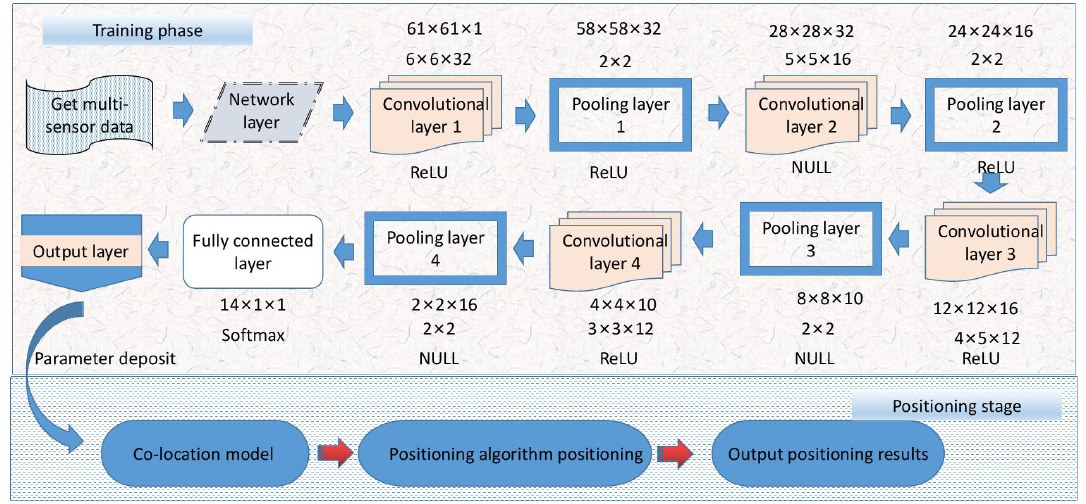
Fig. 1. Multi-sensor collaborative positioning model architecture based on dual neural networks